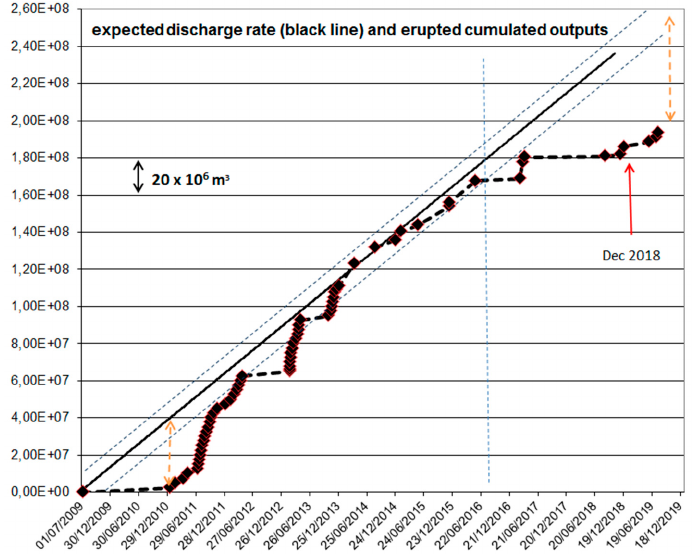
Figure 11. Expected cumulative magma volume (black line with slope 25 × 10 6 m 3 per year) and cumulative erupted volume from the several eruptions (rhombus) at the Etna volcano in the last 10 years. The graph starts from the end of the last flank eruption of 2008–2009.